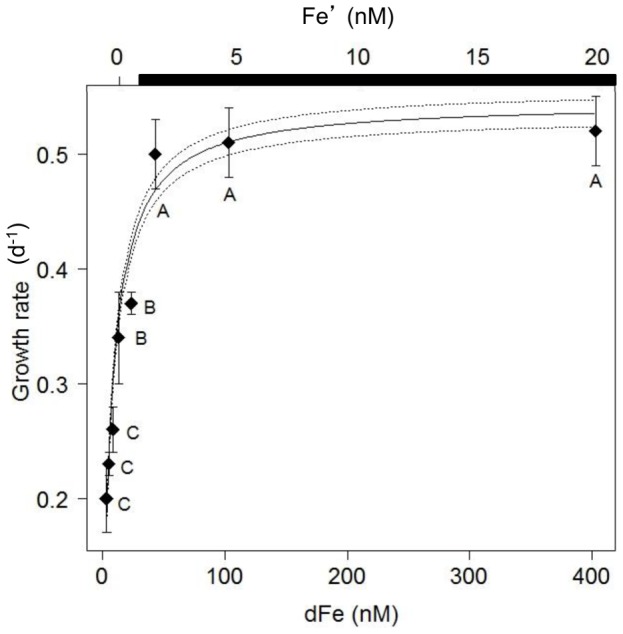
Growth rate of C. watsonii related to dFe and Fe′ concentrations.Error bars represent standard deviation; different letters correspond to statistically different means (p<0.05) and the black bar indicates the region of expected Fe hydroxide precipitation. The Monod regression, performed with dFe concentrations, is represented by the black line and standard deviation of regression by dotted lines.